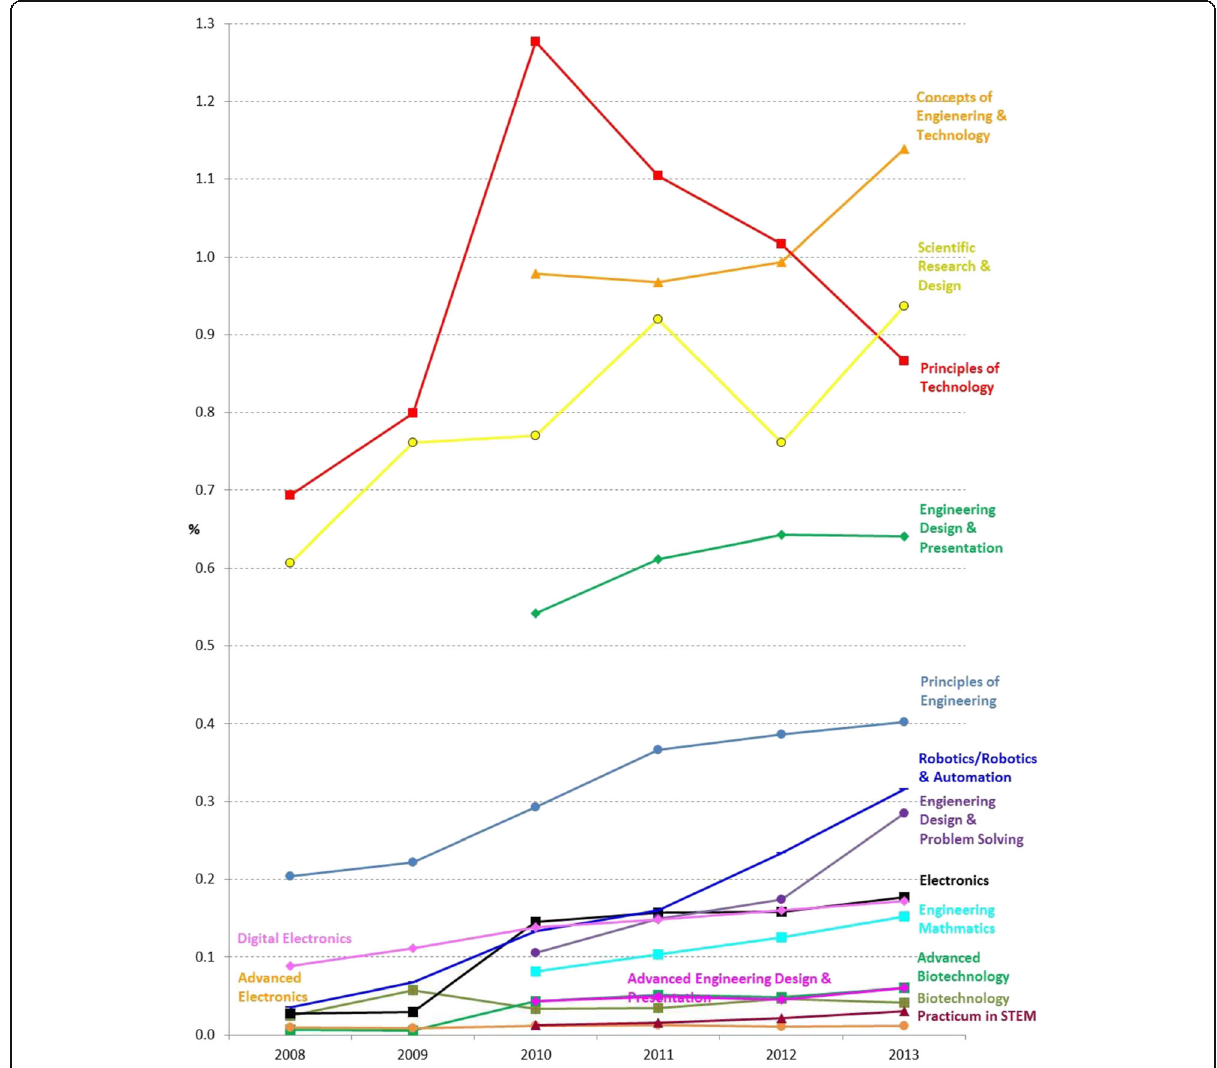
Fig. 9 15 CTE-STEM course enrollment rates in percentage of total number of students from 2008 to